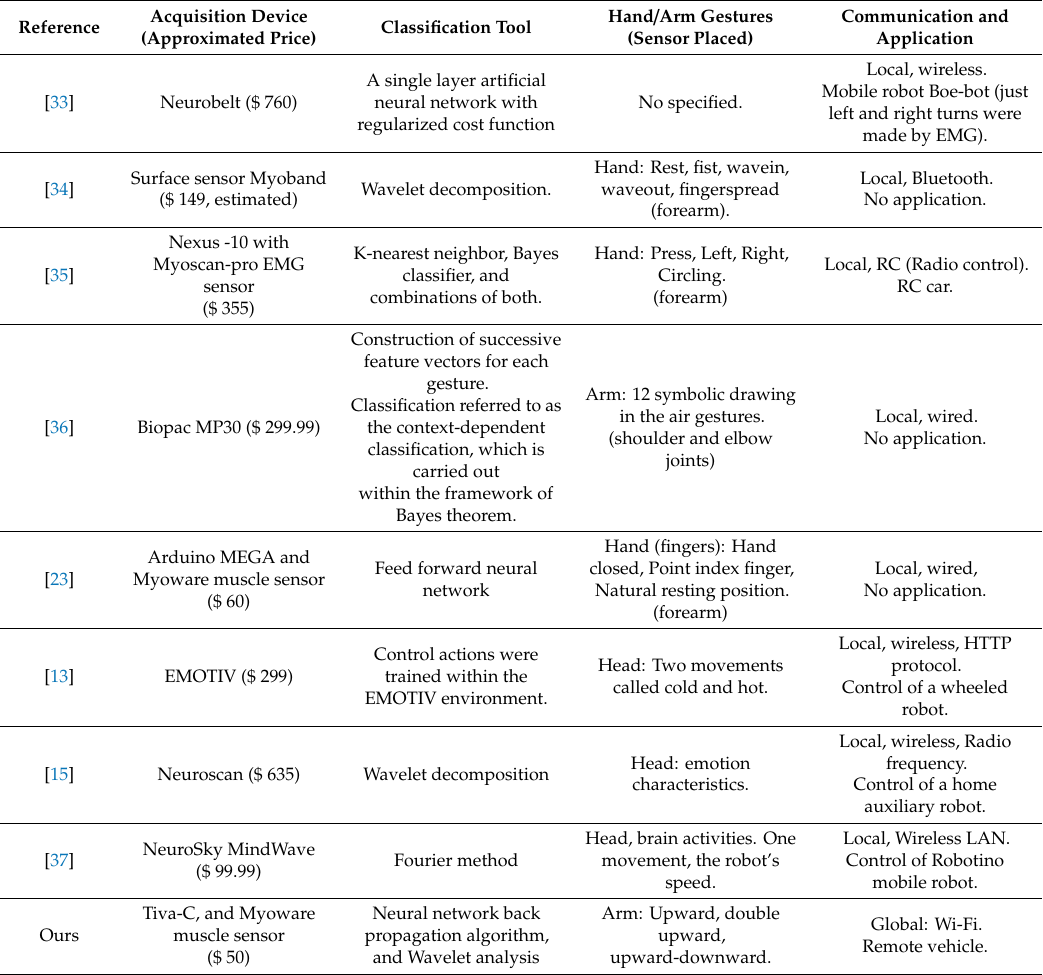
Table 3. Comparison between our proposal and previous EMG-based and brain-computer interface (BCI)